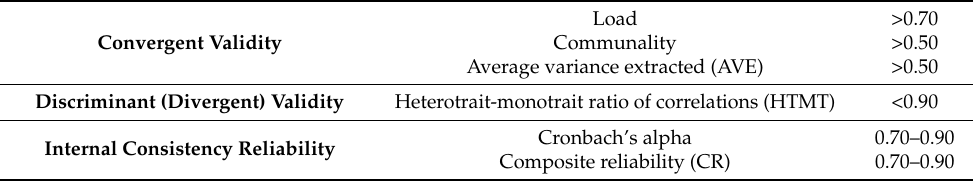
Table 1. Validation measures of the theoretical constructs.